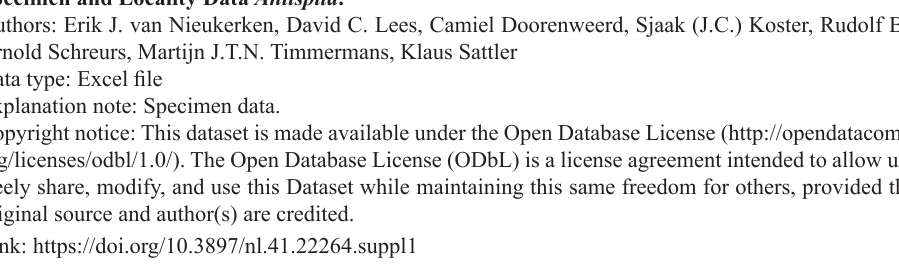
Figure S1. Cornus species, details of leaf underside. a C. sanguinea subsp. sanguinea , fresh leaf, Nether -